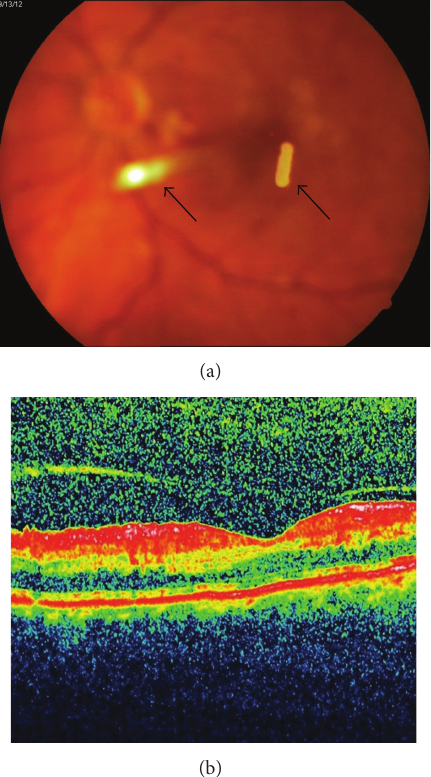
Figure3:(a)Colourfunduspictureatthethirdpostinjectionmonth showing the partly dissipated splitted Ozurdex implant (arrows). (b) Optic coherence tomography demonstrating the resolution of macular edema at the third postinjection